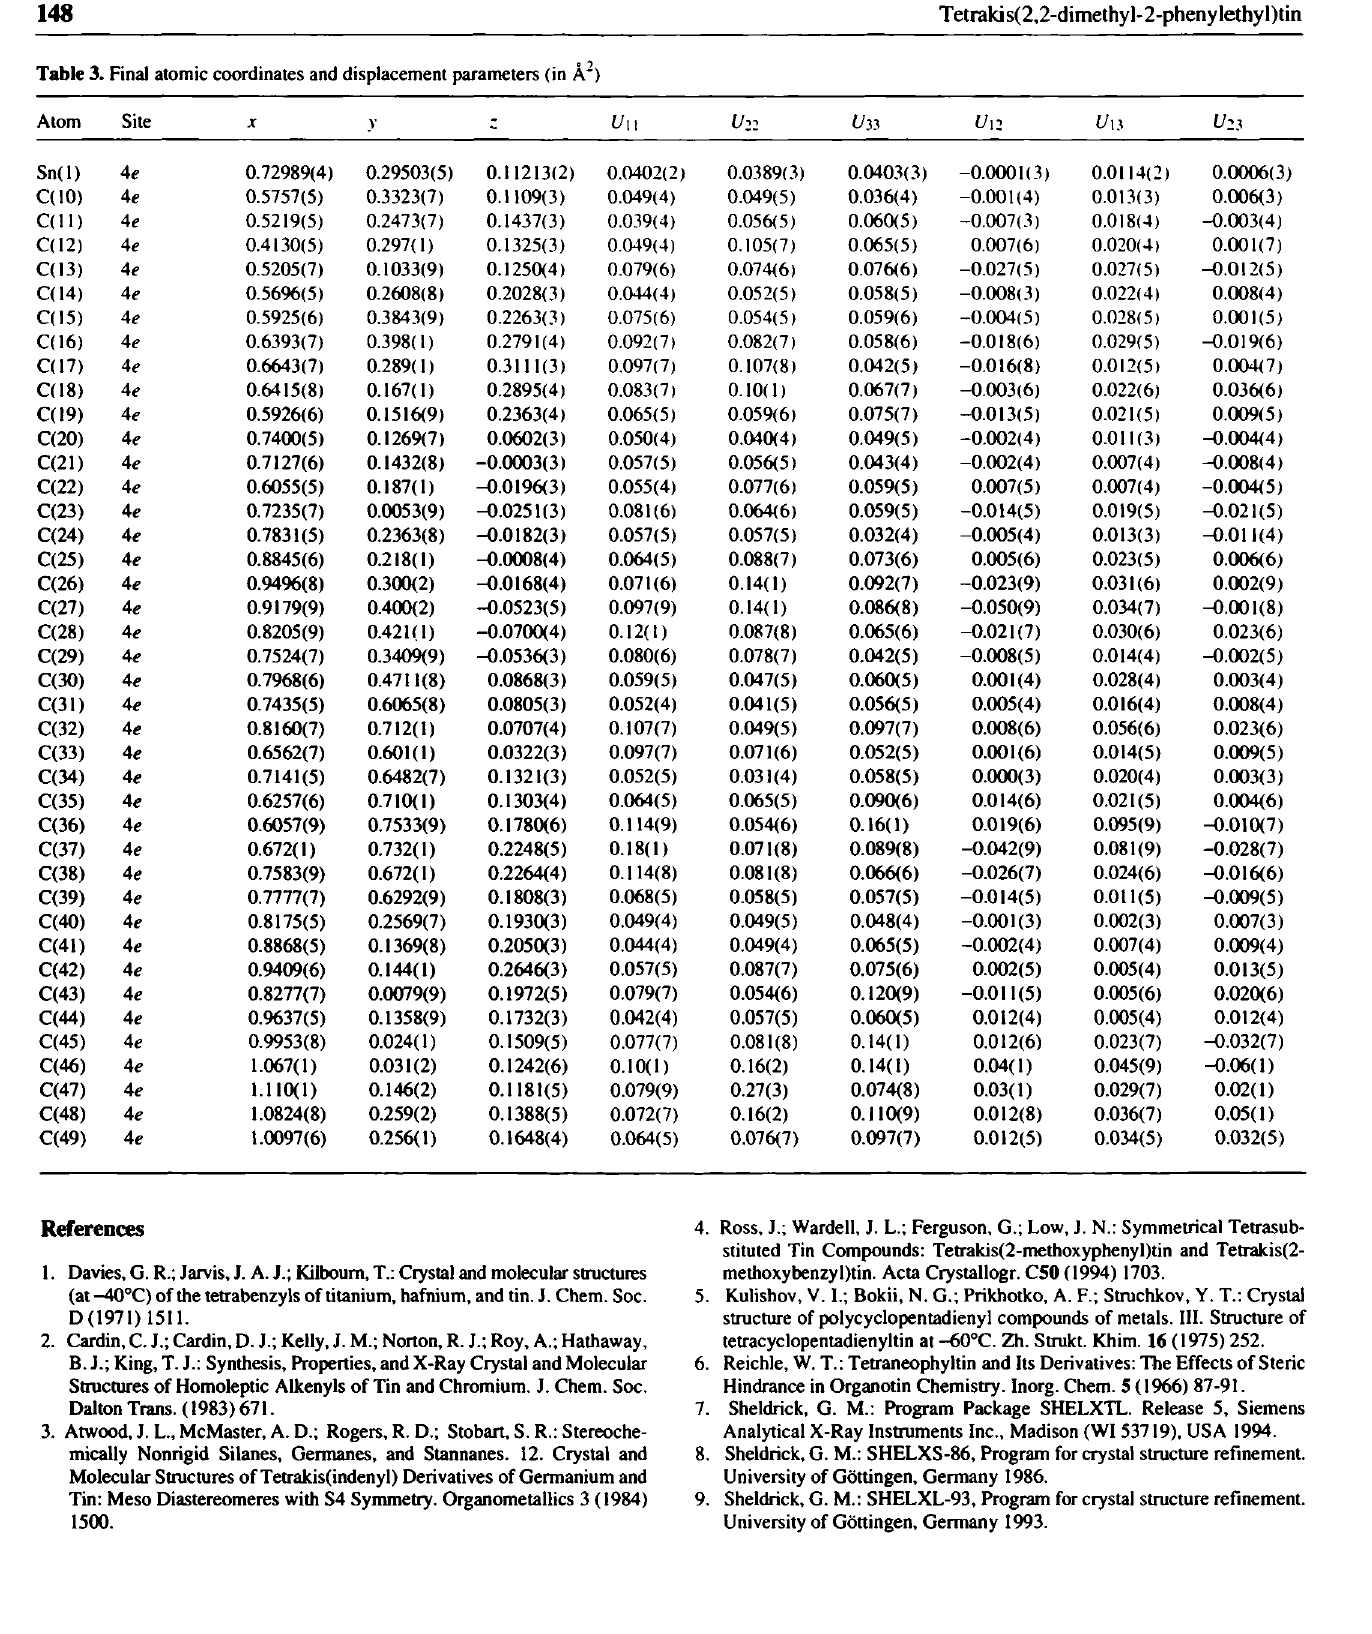
Table 3. Final atomic coordinates and displacement parameters (in A") Atom